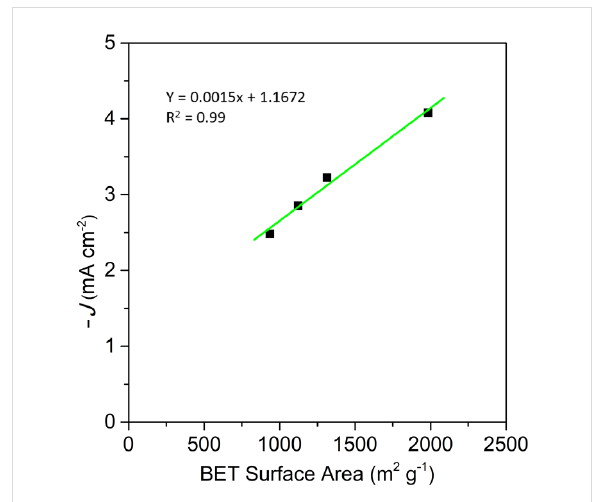
Figure 3: Relationship between BET surface area and the limiting cur- rent density of the activated samples.